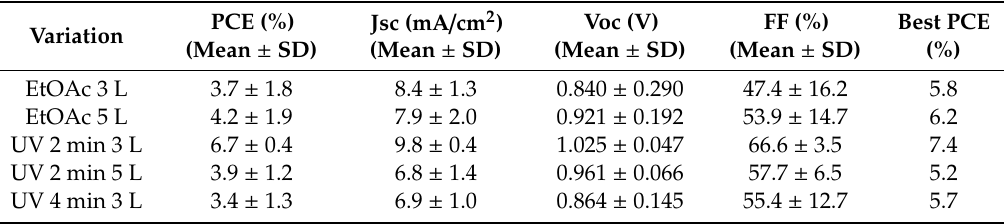
Figure 5. Photovoltaic parameters of the CsPbI 3 perovskite QDs solar cells with different number of layers and UV treatments. EtOAc is the sample in which only the EtOAc washing is used. UV means that each layer was treated with the UV under nitrogen after every washing. Box plots for ( A ) power conversion efficiency, PCE. ( B ) Short circuit current density, J sc . ( C ) Open circuit voltage, V oc . ( D ) Fill factor, FF. ( E ) J–V curves of the best solar cells employing 3 layers of CsPbI 3 QDs stacked by washing (EtOAc) and washing + UV treatment. ( F ) IPCE curves of encapsulated solar cells with 3 layers of CsPbI 3 QDs as light absorber with and without UV treatment. Table 2. Mean and standard deviation (SD) for the photovoltaic figures of merit of devices with different number of QDs layers.